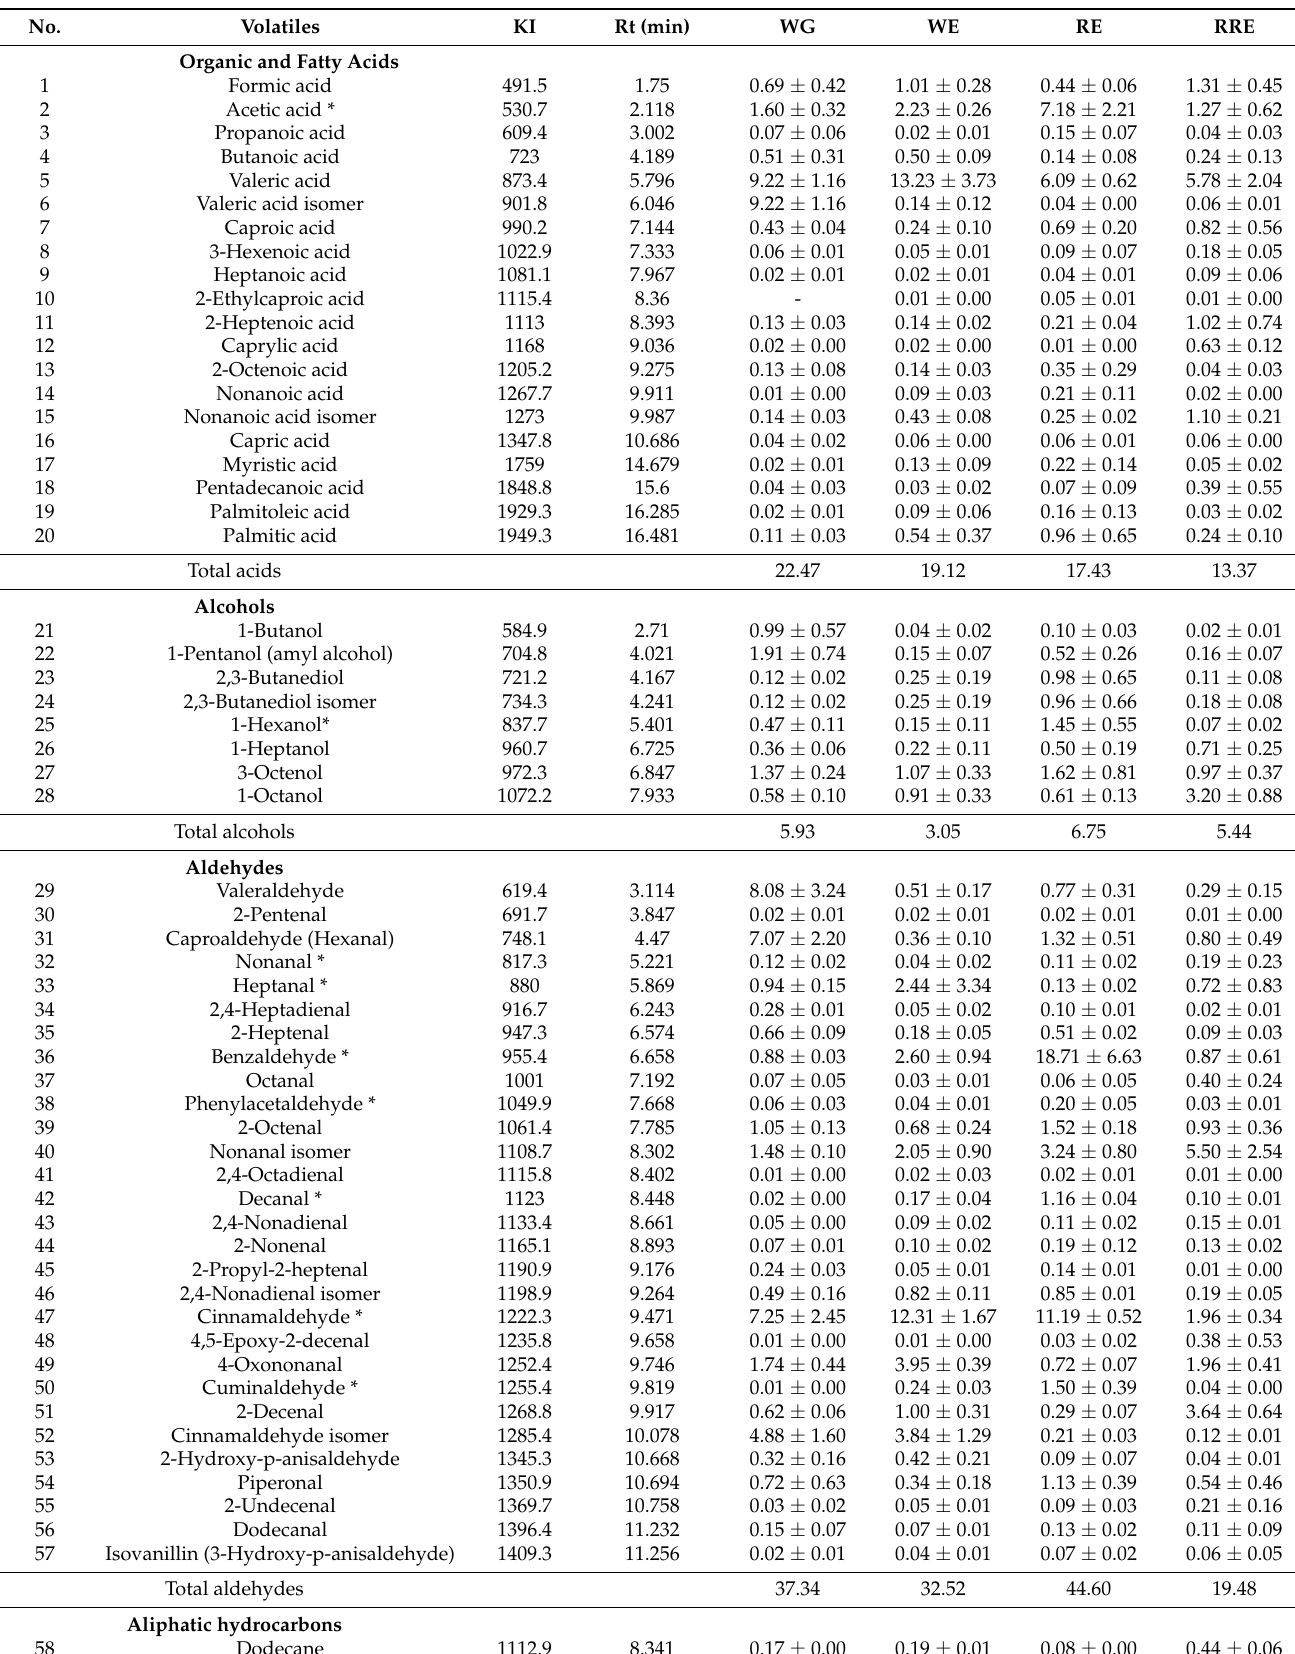
Table 3. Relative percentage of volatile constituents in P. mahaleb seeds analyzed using SPME–GC–MS, n = 3. For codes, refer to Table